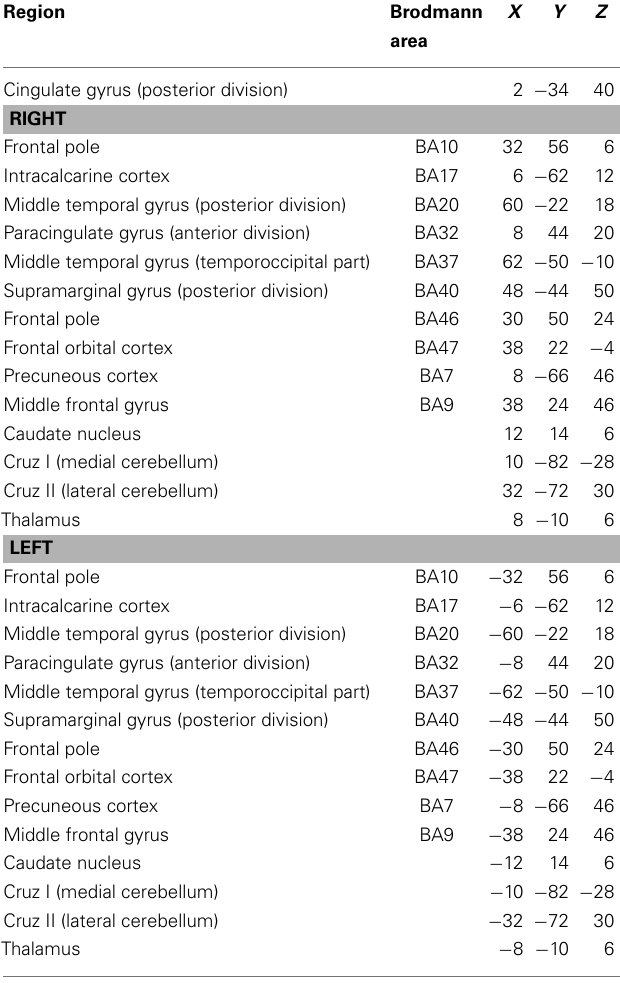
network, their corresponding Brodmann area and MNI coordinates of the center of each sphere